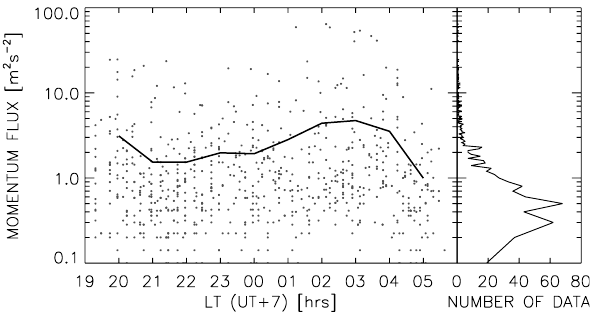
Fig. 4. Variations in the momentum flux magnitudes (log scale) with local time and distributions of the magnitudes. The solid curve in the left panel indicates the hourly